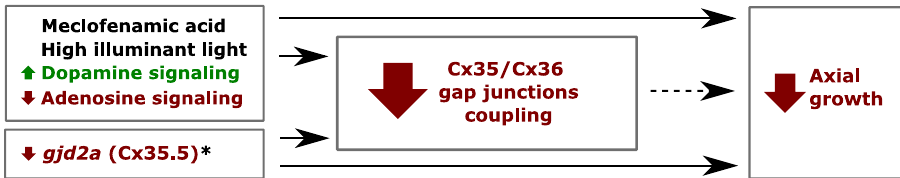
Fig. 8 Gap junction regulators and the effect on axial growth. Simpli fi ed illustration summarizing the relation between (un)coupling of retinal gap junctions and axial eye growth. We hypothesize, based on reported literature and the outcome of this study (asterisk), that the (un)coupling of retinal gap junctions may play an intermediate role in controlling emmetropization. The exact mechanism of how Cx35/Cx36 uncoupling leads to reduce axial eye growth is unclear (dotted line